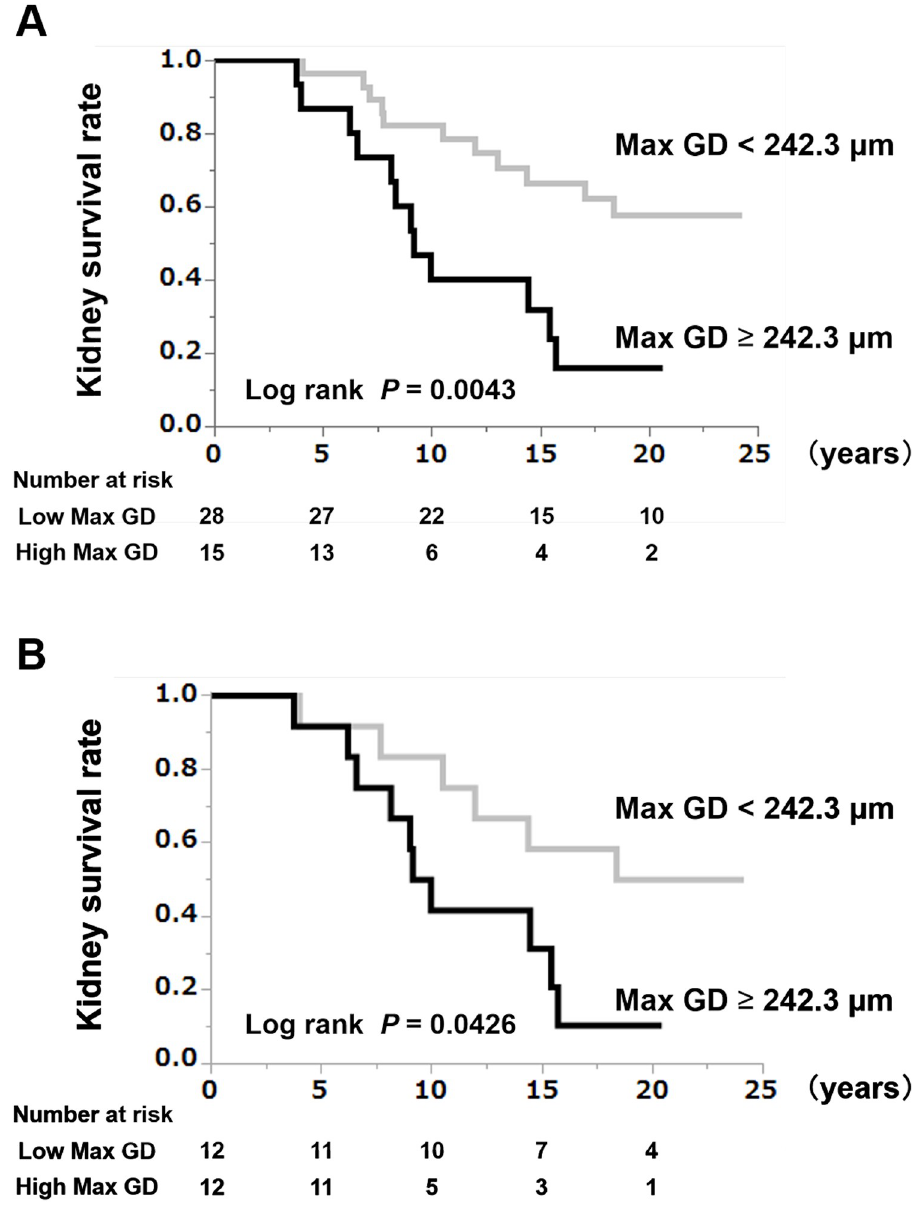
Fig 1. (A) Kidney survival rates in the high-Max GD group (Max GD � 242.3 μ m) and low-Max GD group (Max GD < 242.3 μ m) within the entire cohort. The renal prognosis for patients with glomerular hypertrophy with a Max GD � 242.3 μ m was poor. Max GD: maximal glomerular diameter. (B) Kidney survival rate in the high-Max GD group (Max GD � 242.3 μ m) and low-Max GD group (Max GD < 242.3 μ m) in the propensity score-matched cohort. The renal prognosis for patients with glomerular hypertrophy and a Max GD � 242.3 μ m was poor after matching the groups for age and eGFR. Max GD: maximal glomerular diameter; eGFR, estimated glomerular filtration rate.